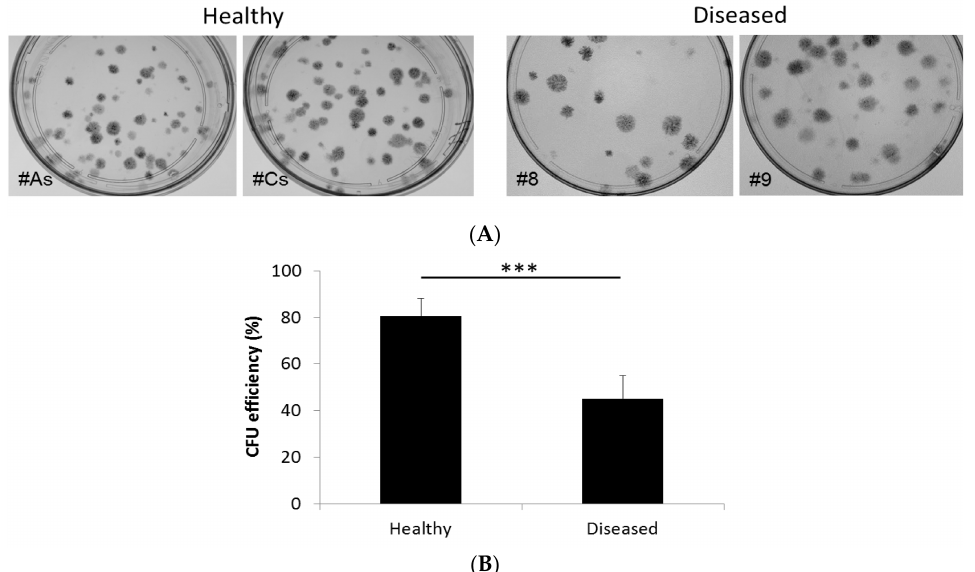
Figure 2. CFU efficiency adherent cells derived from healthy and diseased gingiva after 14 days of culture. ( A ) Representative photographs of the plates after staining with crystal violet; ( B ) Quantification of CFU efficiency shows a significant difference between the two types. *** t -test, two- tailed p -value <0.0001.